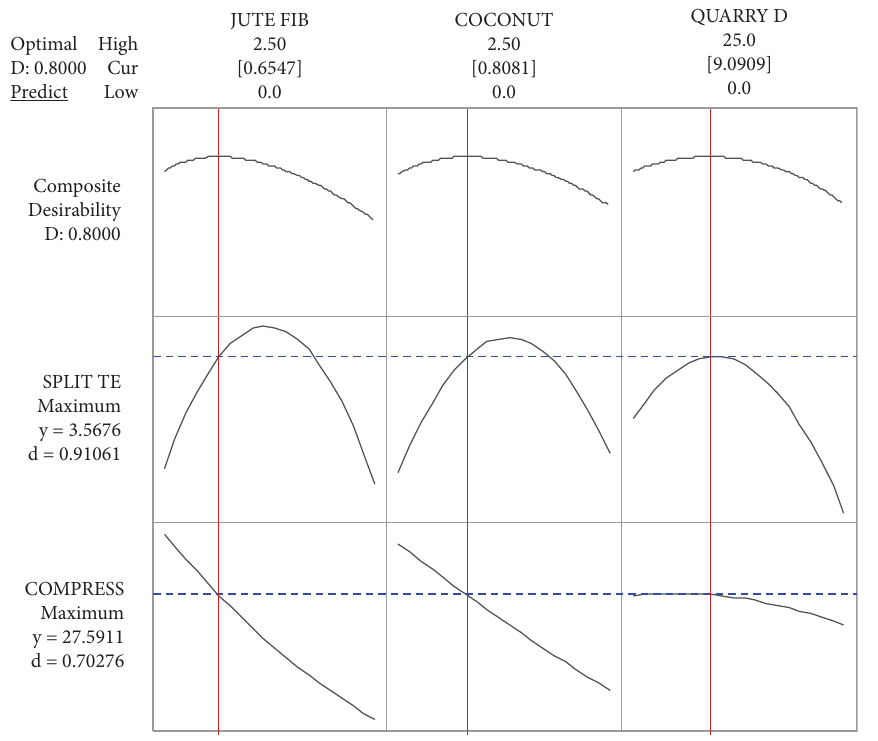
Figure 9: Response optimization for compressive and split tensile strengths.